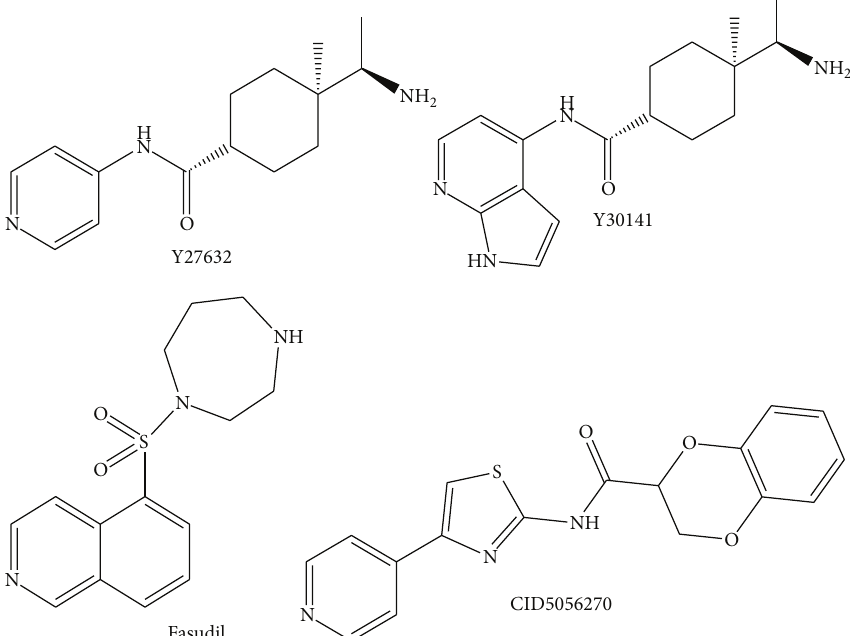
Figure 1: Structure of ROCK